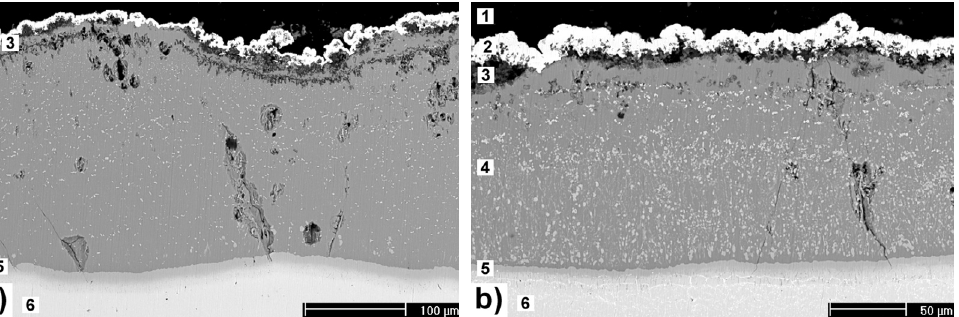
Figure 9. Cross-sections of aluminized specimens after 336 hours at 883 K in N 2 (cid:3) 1000 ppmv HCl (cid:3) 100 ppmv SO 2 (cid:3) 10 % H 2 O (cid:3) 8:4 % O 2 . a) P91. b) HCM12A. On both images: 1) Mounting. 2) Nickel coating. 3) (cid:2) -Al 2 O 3 . 4) Al 5 Fe 2 matrix phase (as grey in images) with AlCr 2 and Cr 3 Si precipitate phases (both as white in images, with the latter shown slightly brighter). 5) AlFe phase. 6)